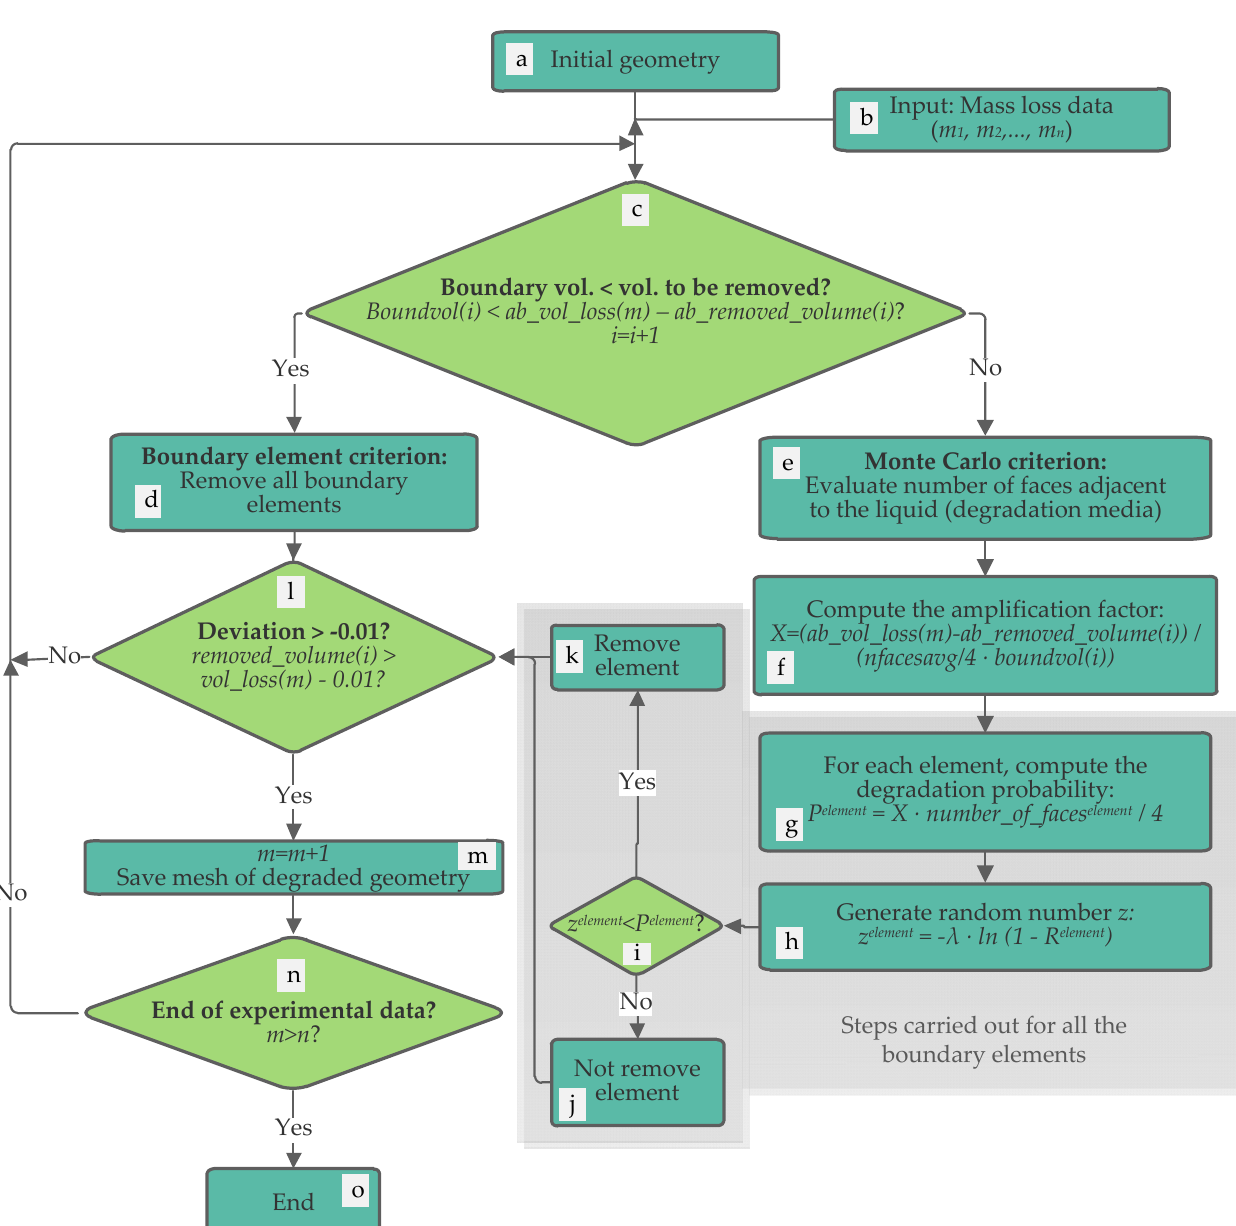
Figure 1. Flow chart of the proposed method to simulate the enzymatic degradation using the experimental data of mass loss as reference values to adjust the degradation and predict the degraded geometry. This methodology was applied in two different cases (PCL and PCL:MCC 98:2